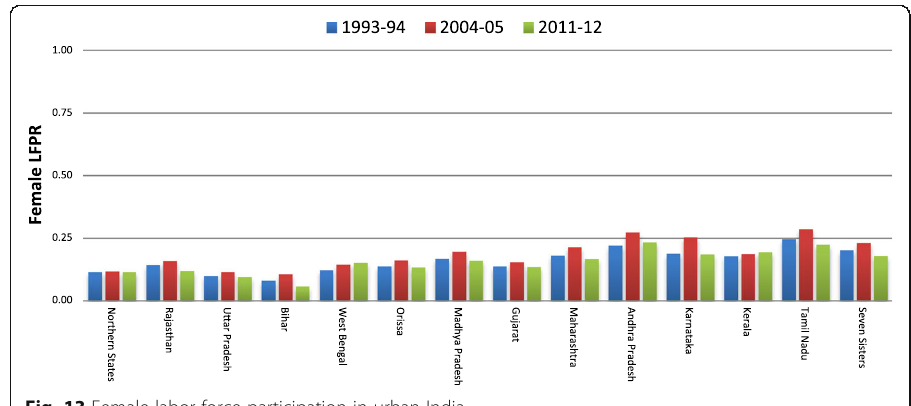
Fig. 13 Female labor force participation in urban India